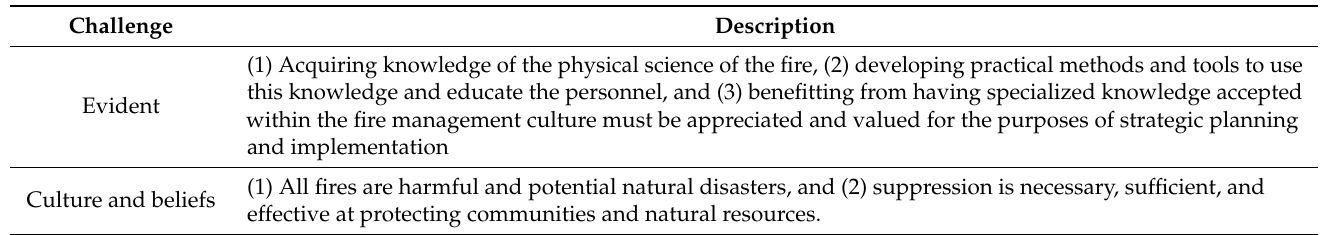
Table 2. Challenges for DSS in wildland fires according to Finney